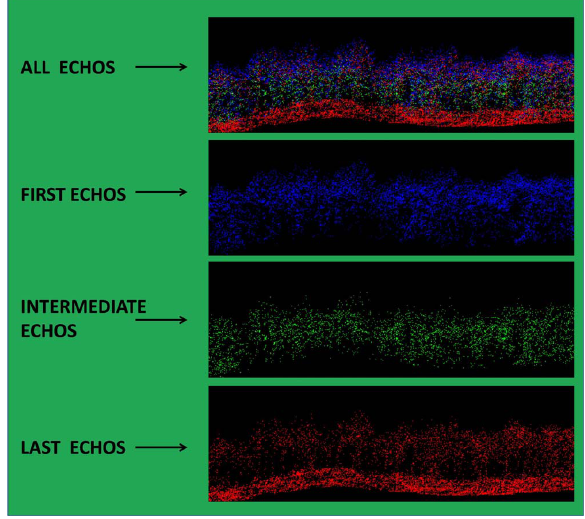
Figure 2 Examples of multiple returns from Lidar Fig. 2. Examples of multiple returns from